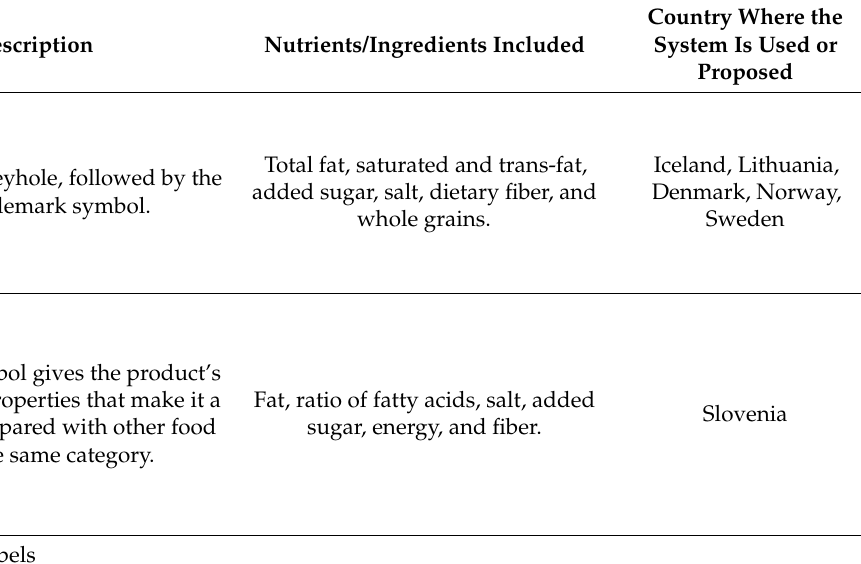
Traffic light color coding: Interpretive (color) and non-interpretive (%RI). Color coding indicates high (red), medium (amber), and low (green) levels of negative nutrients. Energy is depicted in greyscale. Single symbols used for sugar (spoon), sodium (saltshaker) and saturated fat (solid fat and knife), with text “high in nutrient”. Back of pack displays the amount of calories, sugar, sodium, and saturated fat in bold font.